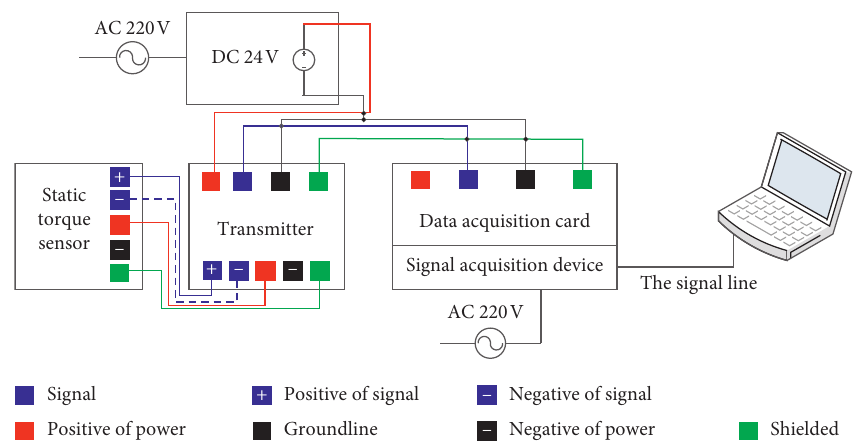
Figure 9: Schematic diagram of signal acquisition system.